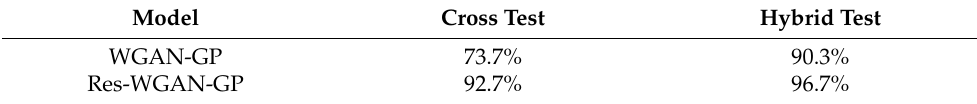
Table 2. The performance of the generated image on the classification model.